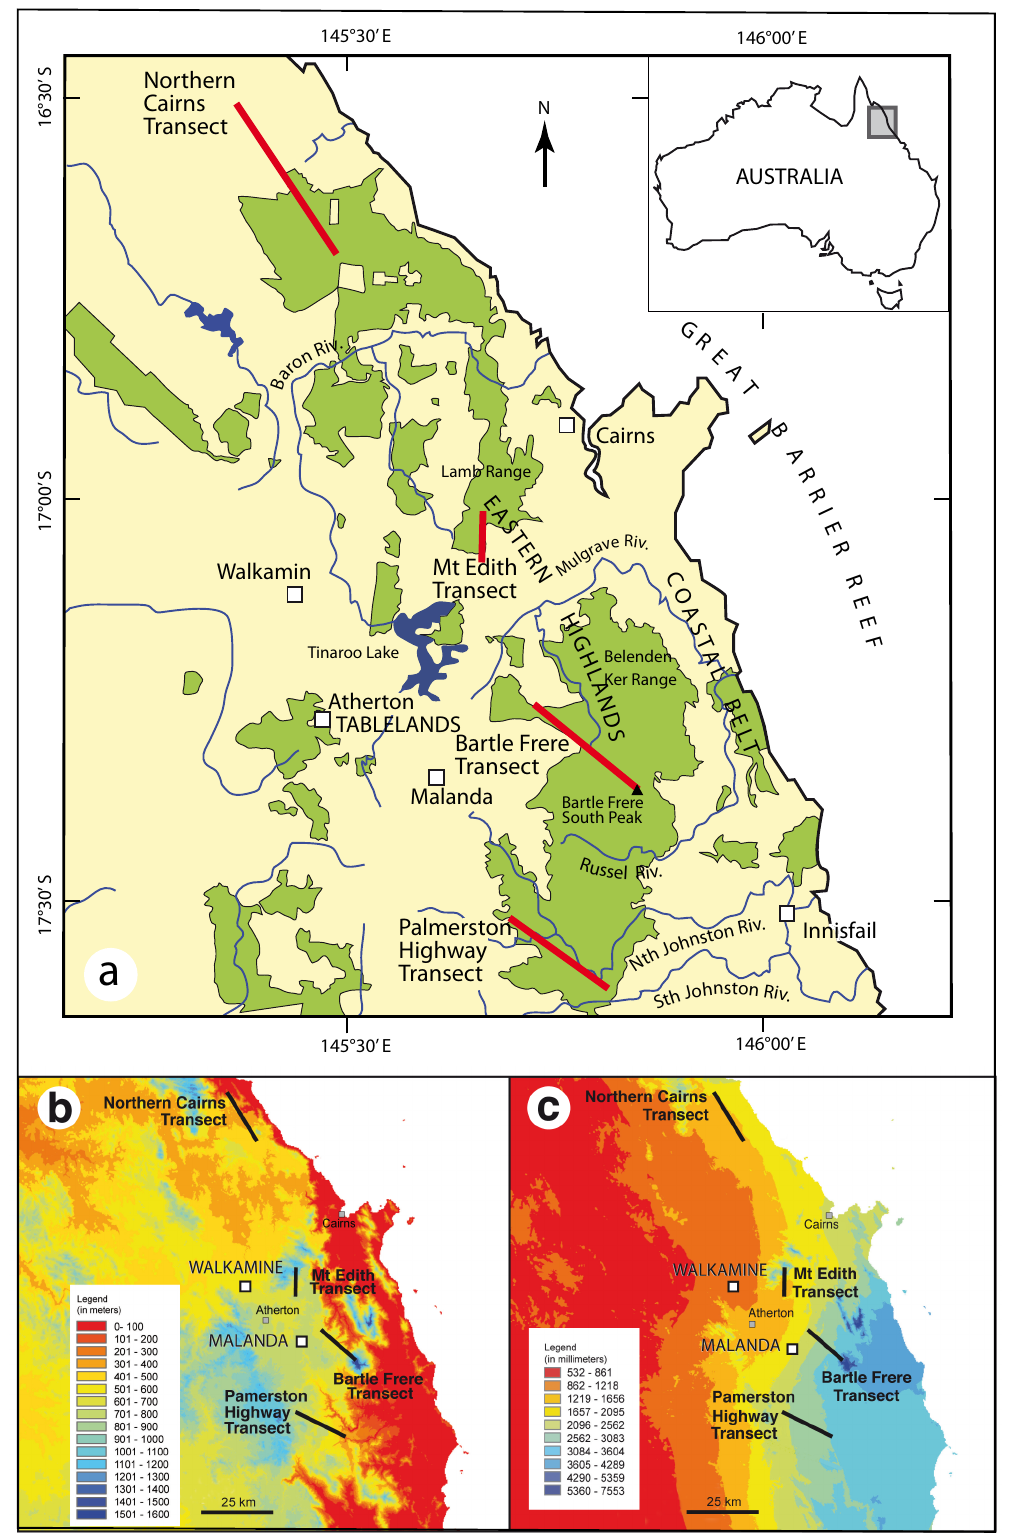
Fig. 2. (a) Location of the rainforests area (in green) in the Wet Tropics of Queensland. (b) Altitude and (c) mean annual precipitation (MAP) maps generated by the ANUCLIM software (McMahon et al., 1995). Sampled transects and stations of Malanda and Walkamine for which measured δ 18 O precipitation data is available are